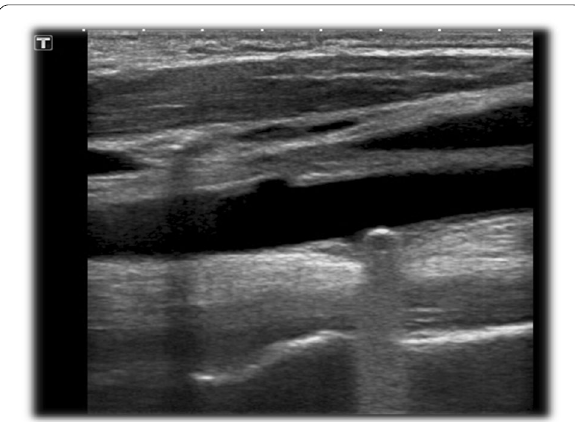
Fig. 2 Ultrasound view of left common carotid artery demonstrating two saccular pseudoaneurysms and